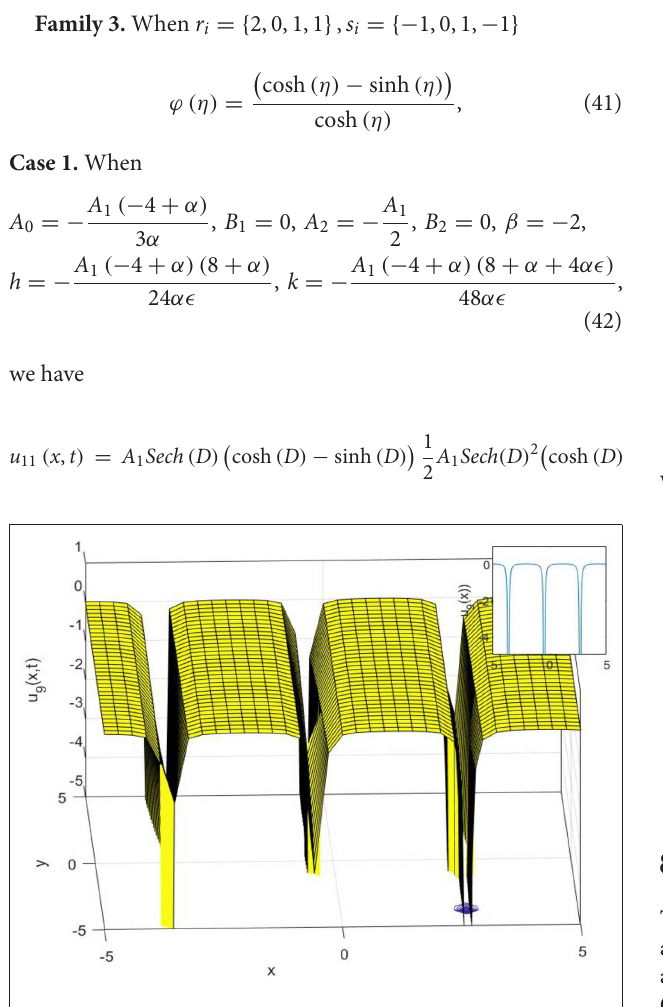
FIGURE 9 | The 3D, 2D, and contour surfaces of Equation (38) using B 1 0.5, α 4, and ǫ 2. = = =